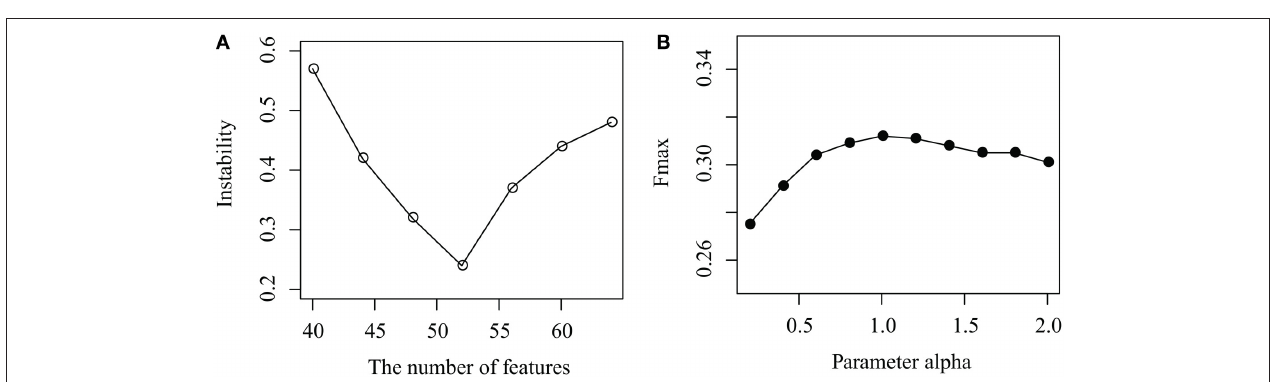
FIGURE 3 | Parameter selection: (A) how instability changes as the number of features k increases, and (B) how the parameter α effects the performance of the proposed algorithm.